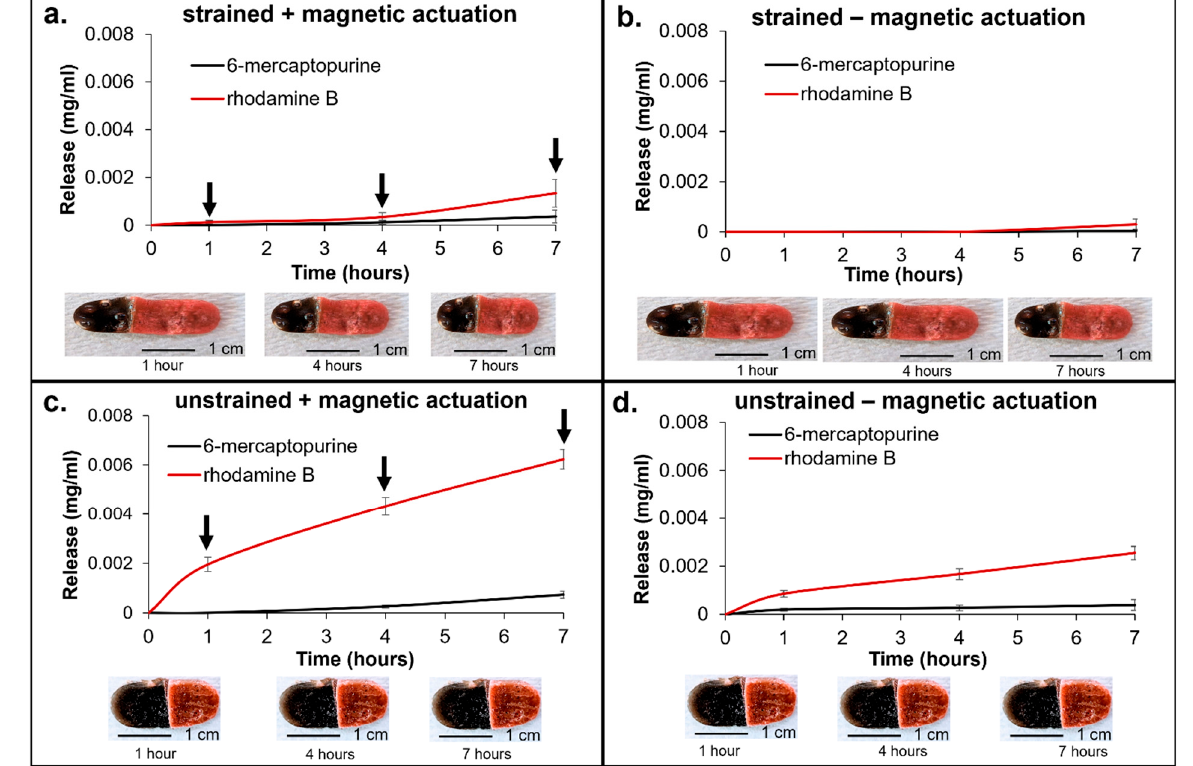
Figure 7. Dual drug release from a single scaffold. Rhodamine and 6-MP were released from strained polymer samples ( a ) under magnetic actuation and ( b ) without magnetic actuation. Rhodamine and 6-MP release rates were measured from the same unstrained samples ( c ) under magnetic actuation and ( d ) without magnetic actuation. The downward arrow indicates time points at which